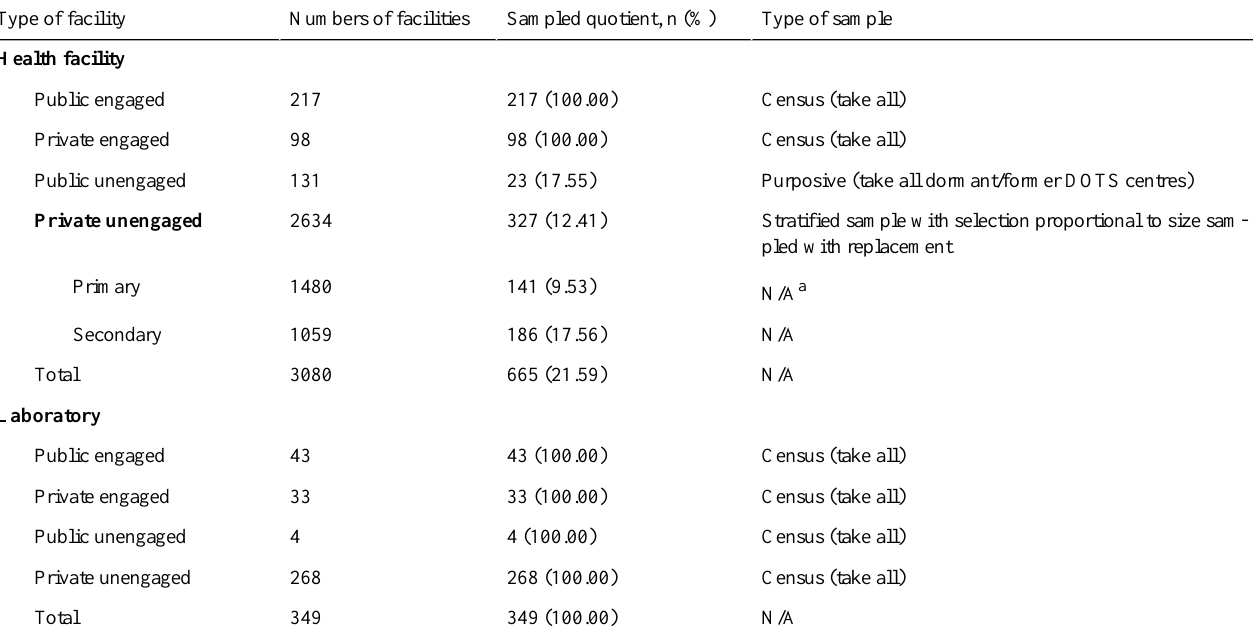
Table 1. Overview of health facility and laboratory sampling